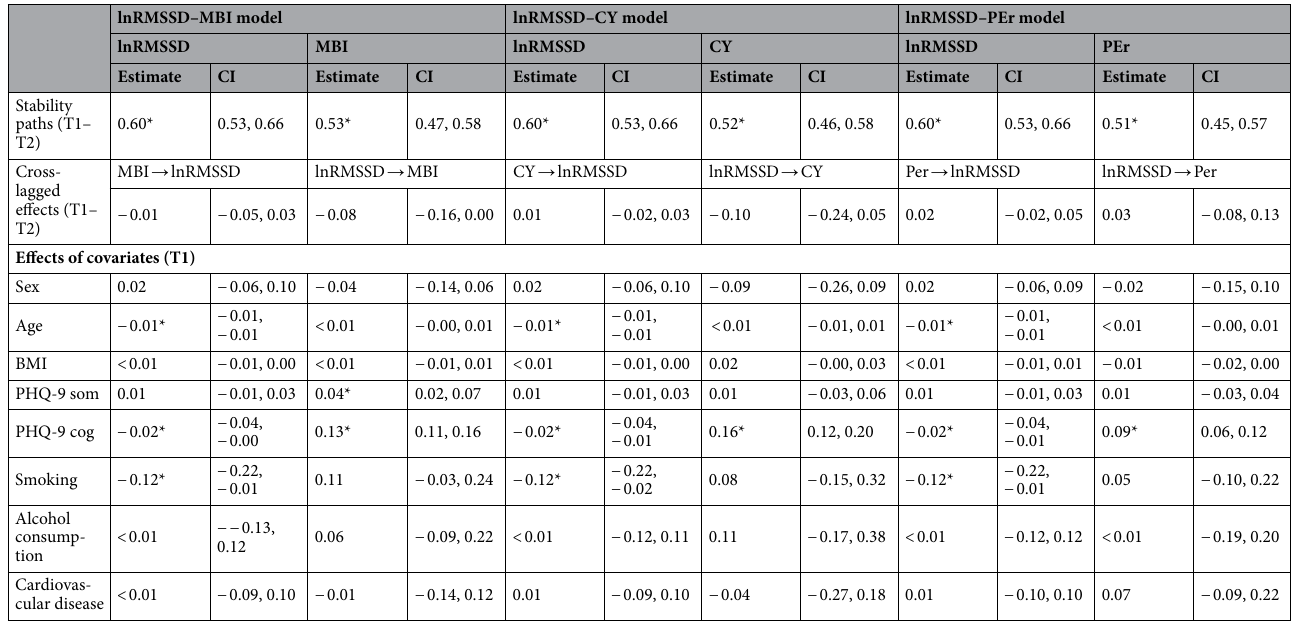
Table 4. Path coefficients of cross-lagged panel models on burnout scores and lnRMSSD with covariates. Sex is coded 0 = male, 1 = female; BMI = body mass index; Cardiovascular Disease = self-reported hypertension